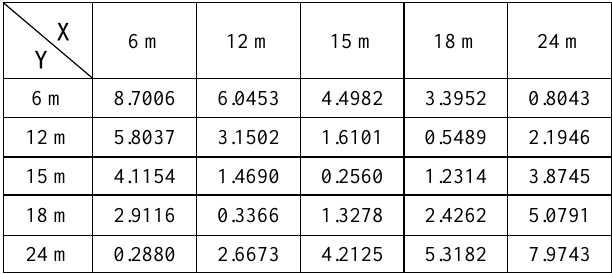
Table 4. Horizontal change, with the vertical direction fixed, 25 points of the two norms